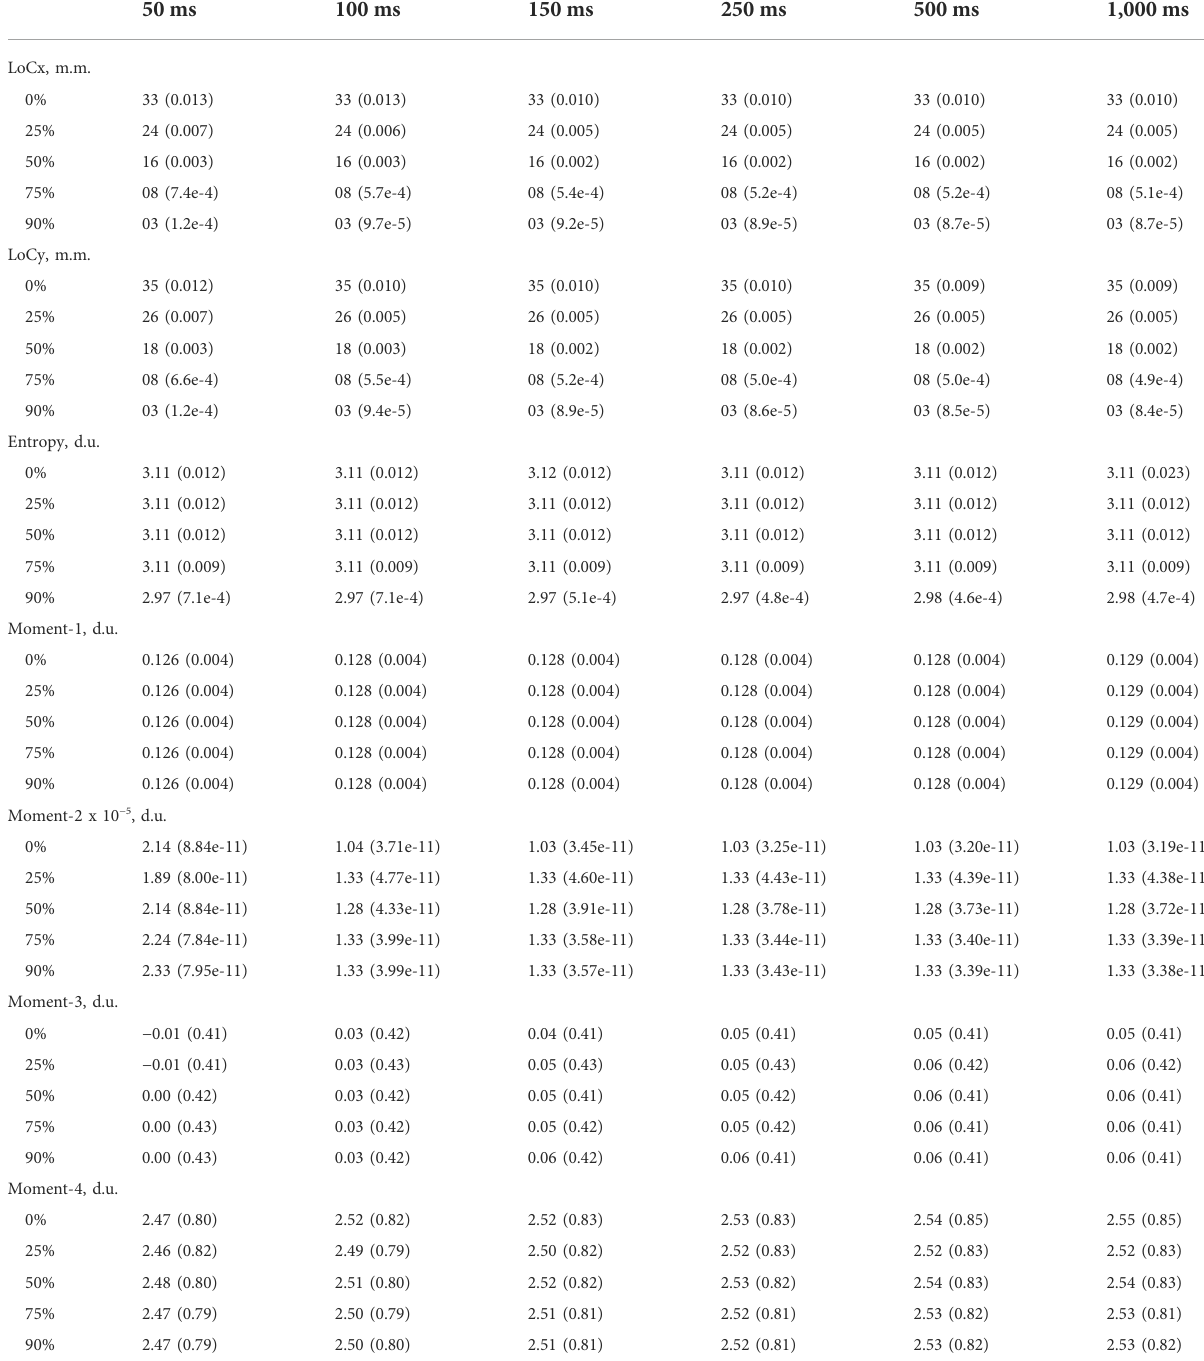
TABLE 1 Topographical EMG map